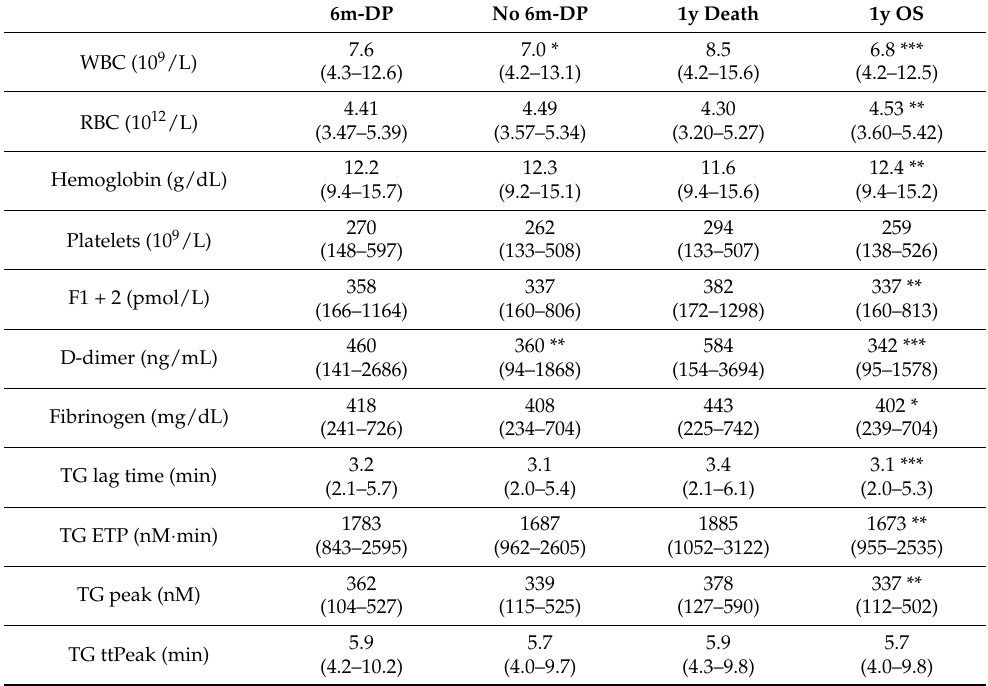
Table 3. Hematological parameters and plasma levels of coagulation biomarkers according to 6m-DP and 1-year